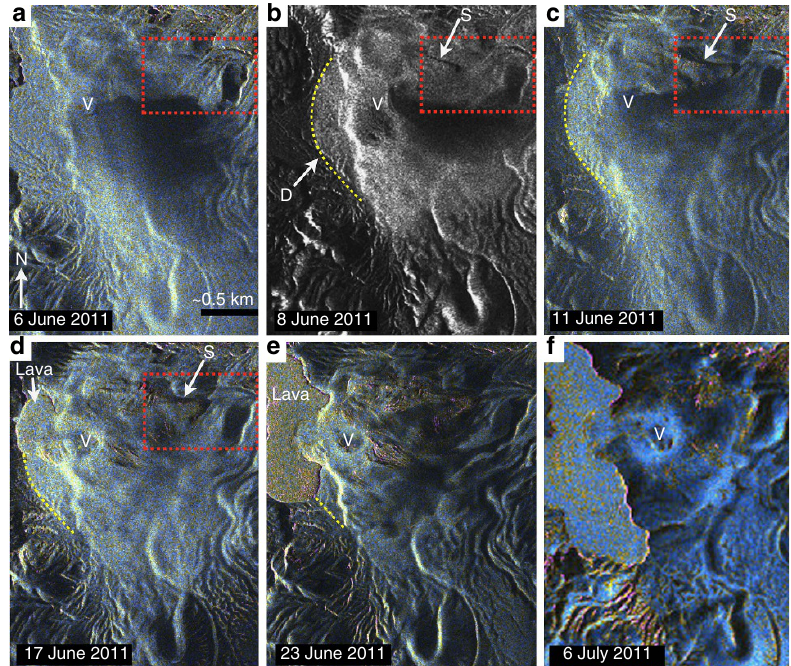
Figure 2 | Syn-eruptive laccolith growth 6 June to 6 July 2011. Radar images (TerraSAR-X; supplied by DLR) spanning the onset and duration of laccolith growth. The dates each respective image were collected are indicated in the lower left of each frame. The first three frames ( a – c ) were captured during purely explosive activity, while the last three images ( d – f ) document the early stages of hybrid explosive-effusive activity whereby lava was also emitted with contemporaneous ash plumes 11 . The red-dashed boxes show the areas exhibiting the earliest signs of syn-eruptive deformation, and comprises the formation of a linear scarp structure, ‘S’, on the 8th of June (see black linear feature) and a broad arcuate area of high radar reflection (indicated by ‘D’ and outlined in yellow dashes) that can be interpreted as sloping ground. The scarp structure lengthens between the 8th and 17th of June, 2011. Additional evidence for syn-eruptive deformation includes the formation of faults structures (pink lines) adjacent to the vent (V) in frame e , and the disappearance of streams located in the eastern extent of the deformation zone (see drainages in centre of red-dashed box in 6 June 2011